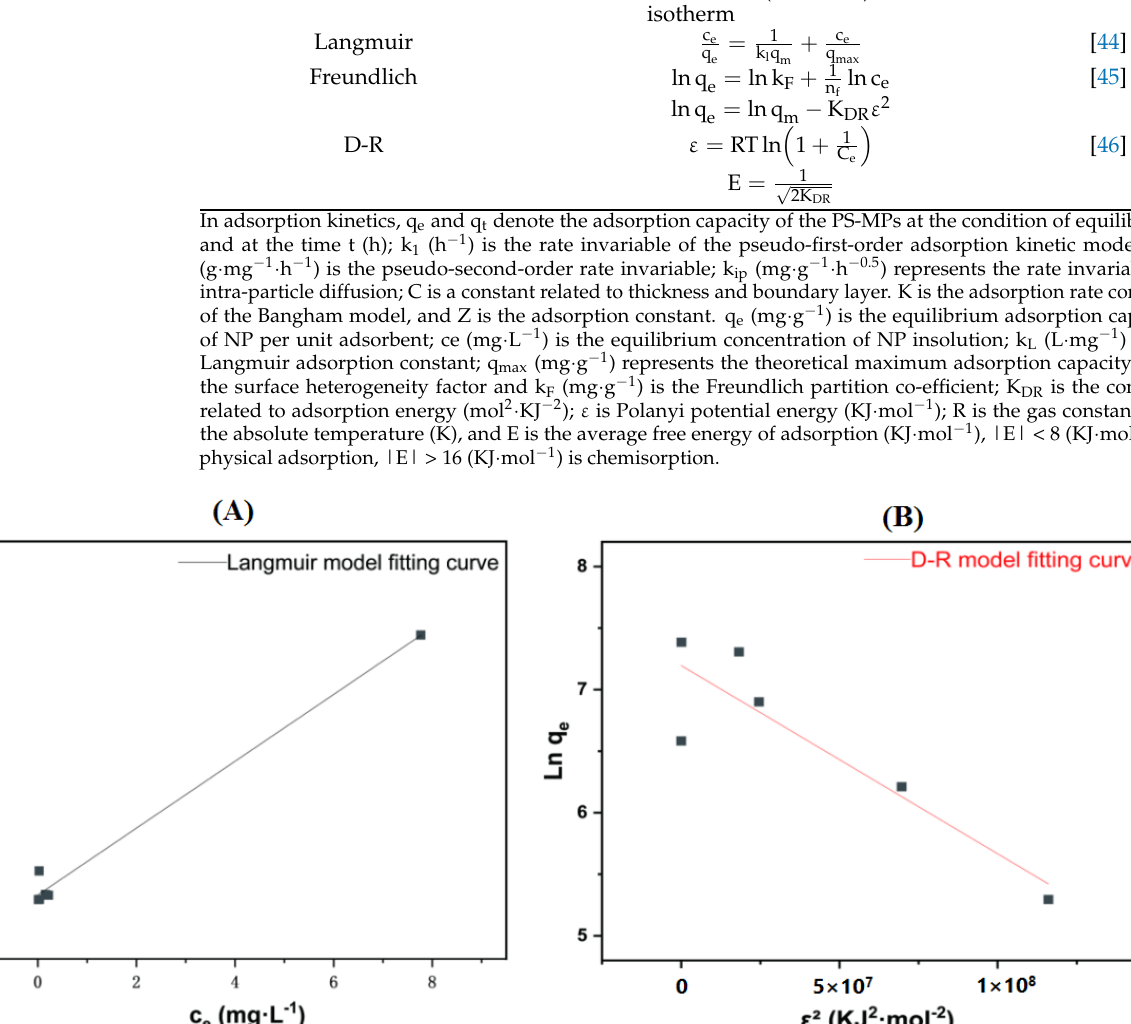
Figure A2. Adsorption isotherm model fitting of 20 μg/mL 0.1 μm of MPs−PS with different concentrations of NP. ( A ) Langmuir model fitting. ( B ) D−R model fitting.